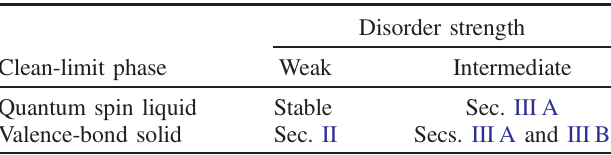
2D lattice system upon adding bond-randomness disorder. In both regimes (defined in Sec. I A) we find a sparse strongly random spin network must necessarily emerge (Figs. 1 and 2), giving rise to interesting low-energy spin